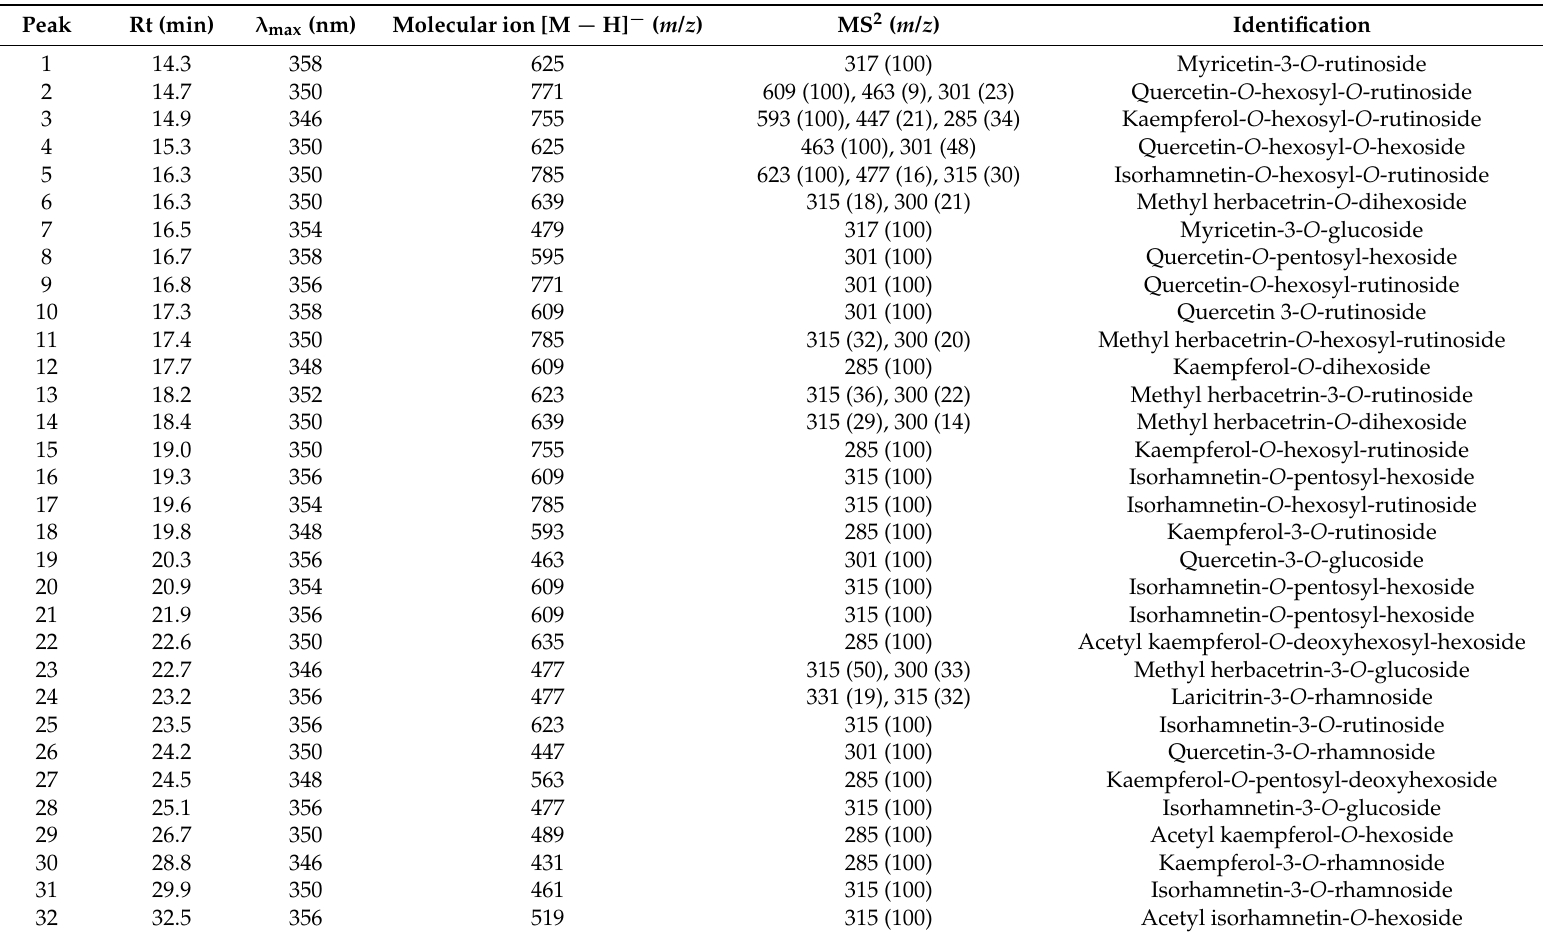
Table 1. Retention time (Rt), wavelengths of maximum absorption in the visible region ( λ max ), mass spectral data and identification of phenolic compounds in bee bread